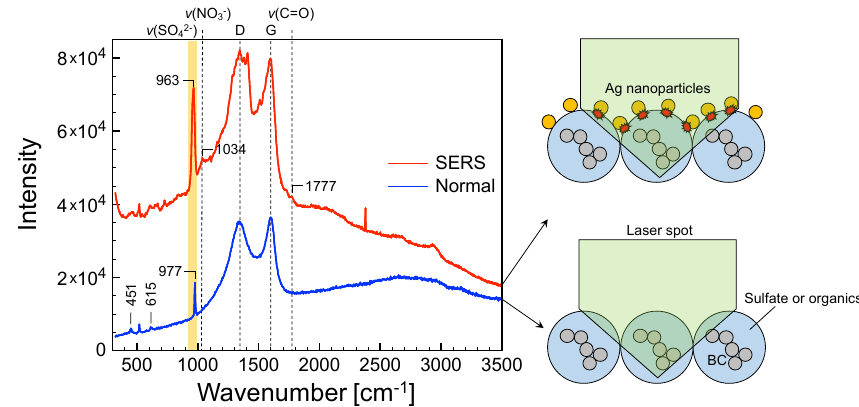
Figure 10. Normal (blue) and enhanced (red) Raman spectra of ambient PM. The particle size is between 0.05 and 0.15µm. Sulfate peaks at 451, 615 and 977cm − 1 and D and G bands at 1341 and 1598cm − 1 , respectively, were observed. Enhanced spectra further showed peaks at 1039 (nitrate) and 1777 (carbonyl group, indicative of organic components) cm − 1 . The illustrations (not to scale) present experimental configurations for normal Raman and SERS measurements. The normal spectrum includes the bulk chemical compositions of BC and sulfate and the enhanced one includes the bulk compositions as well as the surface compositions (i.e., sulfate and